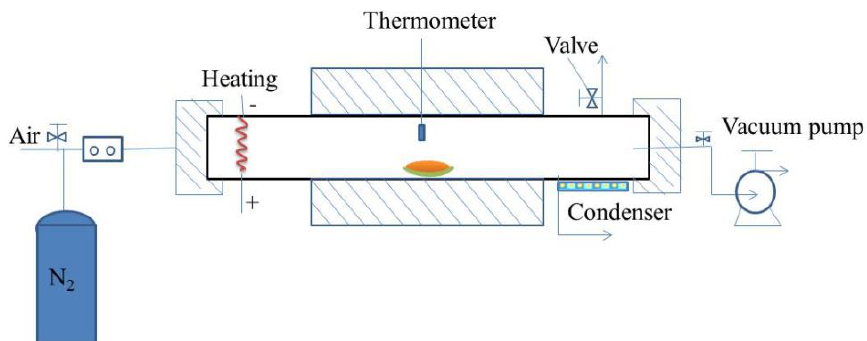
Figure 1. Simulated equipment for the experimental procedure.